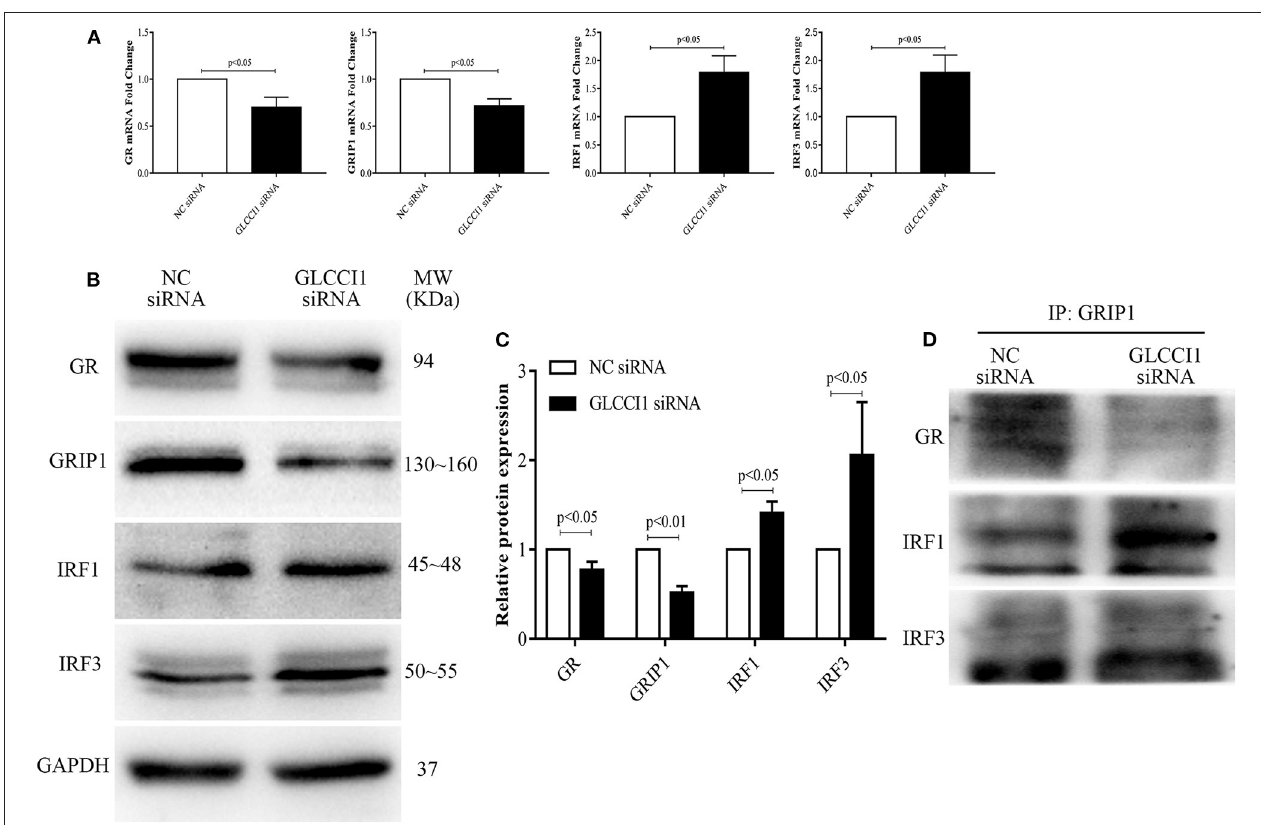
FIGURE 4 | GLCCI1 enhances the binding of IRF1 and IRF3 with GRIP1 and reduces GR and GRIP1 binding in Beas2B cells. Beas2B cells were treated with OVA and Dex in the presence and absence of GLCCI1 siRNA. (A) RT-PCR anylysis of GR, GRIP1, IRF1, and IRF3 mRNA expression. Representative images of protein expression (B) and relative protein levels (C) of GR, GRIP1, IRF1, and IRF3. (D) Anti-GRIP1 antibody was used to capture GR, IRF1, and IRF3 to detect the individual binding of GRIP1 with GR, IRF1, and IRF3. Data are presented as means ± SEM of more than three independent experiments. Intergroup differences as determined by Student’s t